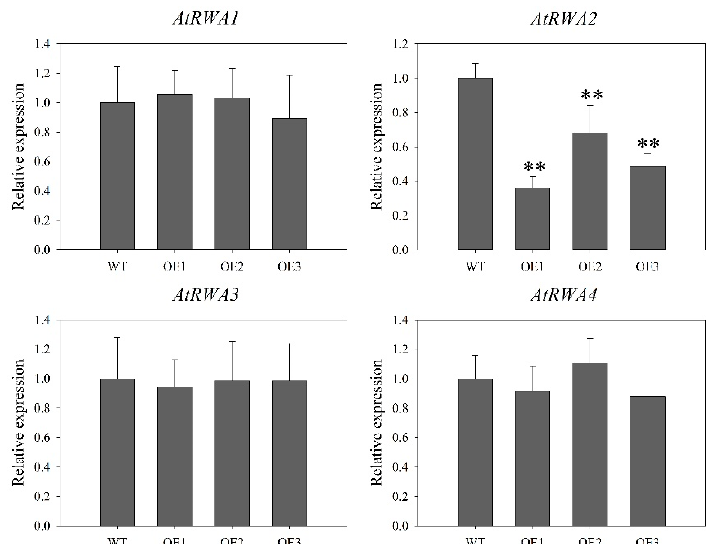
Figure 9. Relative expression levels of four AtRWA genes in the wild type (WT) and three overexpression (OE) 35S::DoRWA3 transgenic lines (OE1, OE2, OE3). The transcript level of AtRWA genes in the WT was set as 1. Each data bar represents mean ± SD ( n = 3). ** indicate p < 0.01 between the transcript levels of three DoRWA genes WT and OE transgenic lines according to DMRT.